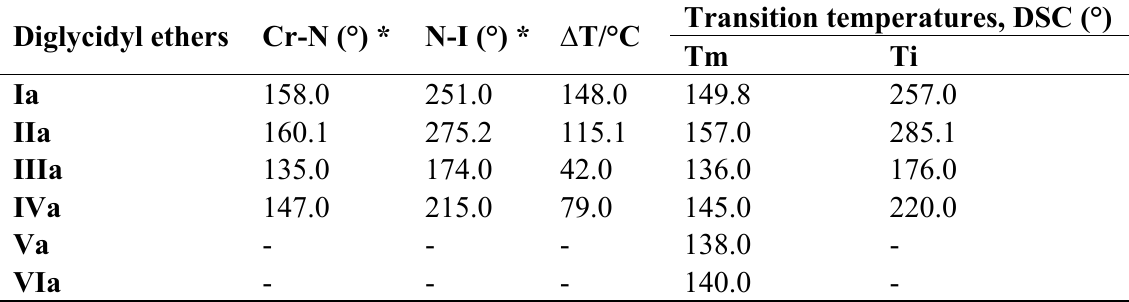
Table 1. Transition point of Ia – VIa